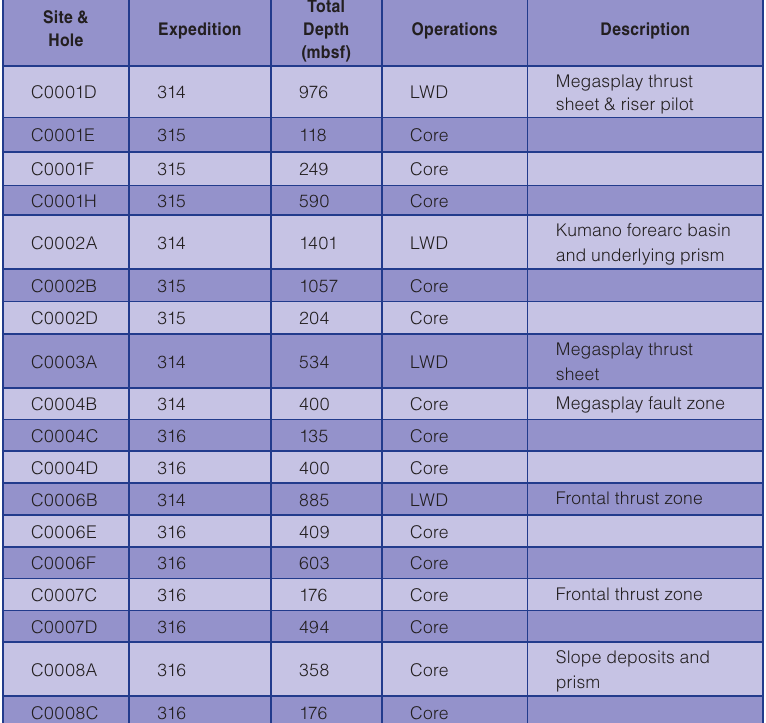
Table 1. Drilling summary for Expeditions 314, 315, and 316 (pilot holes, including Site C0005 where no scientific drilling was done) and very short penetrations omitted). Site &